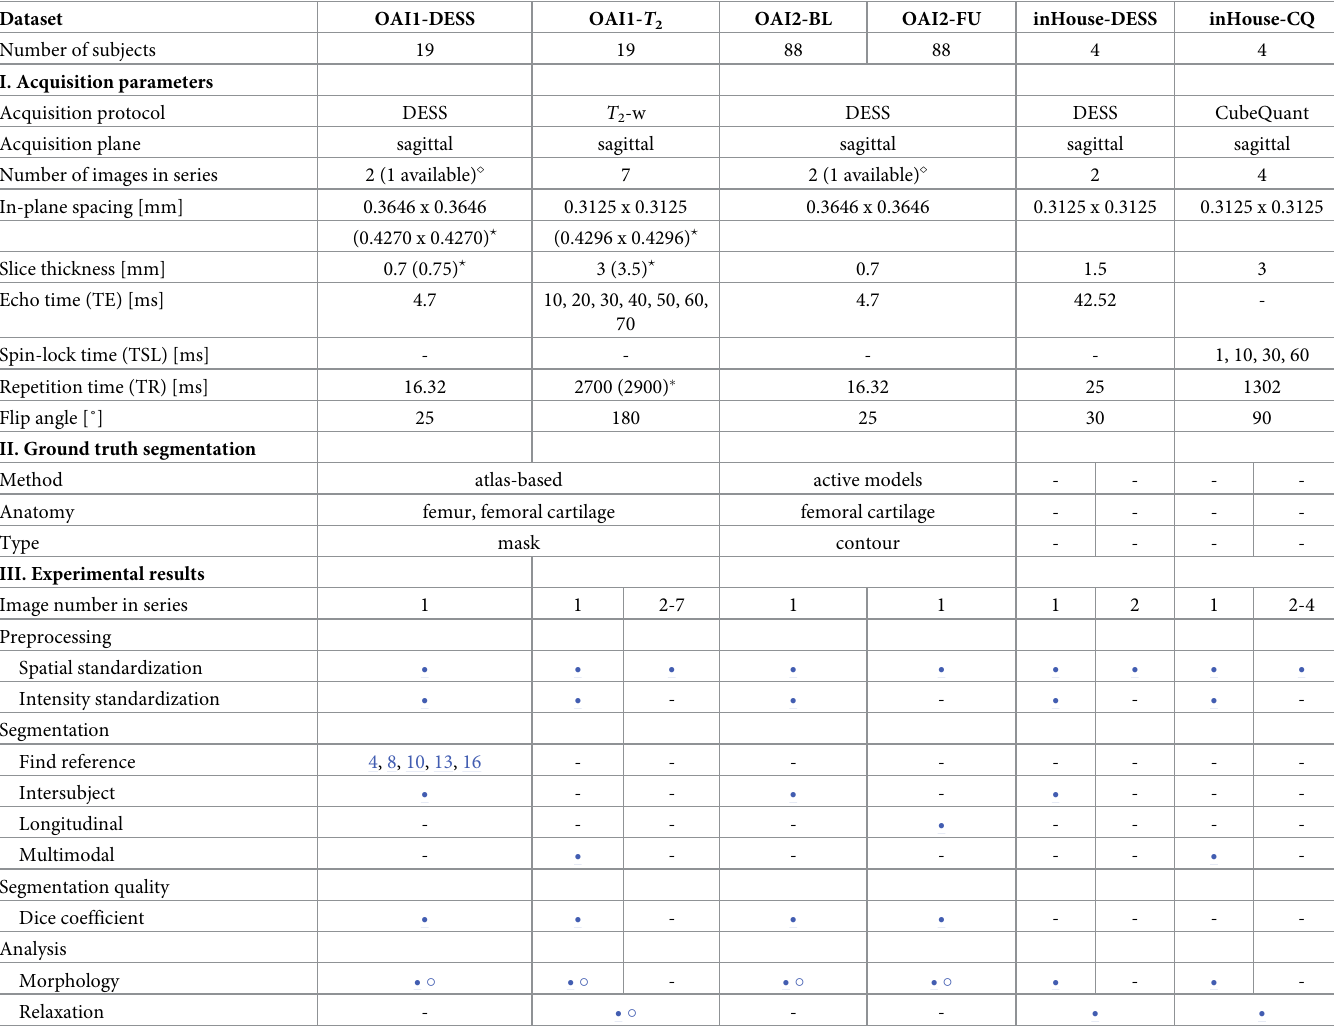
Table 2. Datasets used to evaluate pyKNEEr . I. Acquisition parameters : Parameters of the protocols used to acquire the images. Images of OAI1-DESS, OAI2-BL, and OAI2-FU were acquired with the same DESS protocol, consisting of 2 echos, although only their average was available ( � ). Images of one subject of the dataset OAI1 had different slice spacing and thickness ( ? ). Data queries to obtain acquisition parameters are in a Jupyter notebook (here). The original identification numbers (IDs) of the OAI images are in a Jupyter notebook used as a metafile (here). II. Ground truth segmentation : The datasets OAI1 and OAI2 have ground truth segmentations. They differ for computational method, segmented anatomy, and label type. III. Experimental results : Details of the steps in pyKNEEr for each dataset. Full circle (•) indicates process- ing of the dataset, while empty circle ( � ) indicates processing of ground truth segmentations. The numbers in “Find reference” indicated the ID of the seed images used in the convergence study. Links are to the executed notebooks on